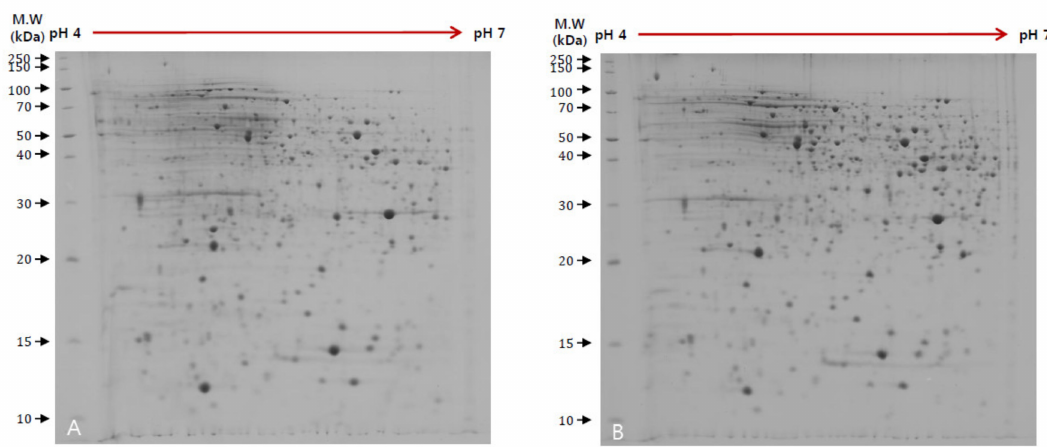
Figure 2. Representative 2D electrophoresis image of LE.; ( A ): Blue light (BL), ( B ): Lightless